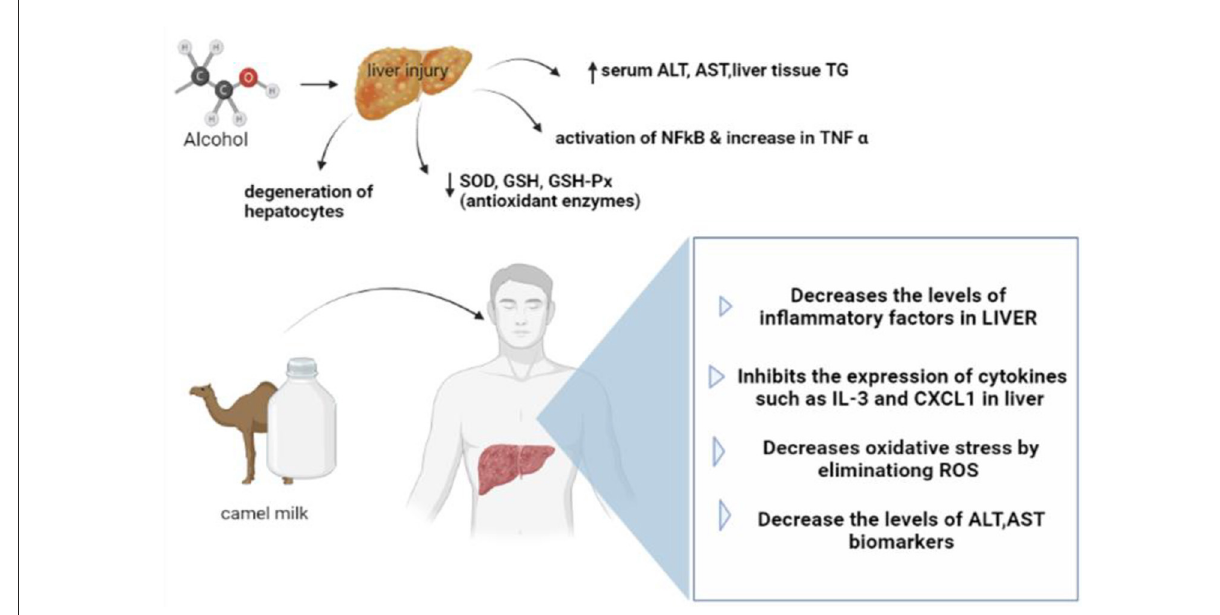
FIGURE3 Effect of camel milk on alcoholic liver